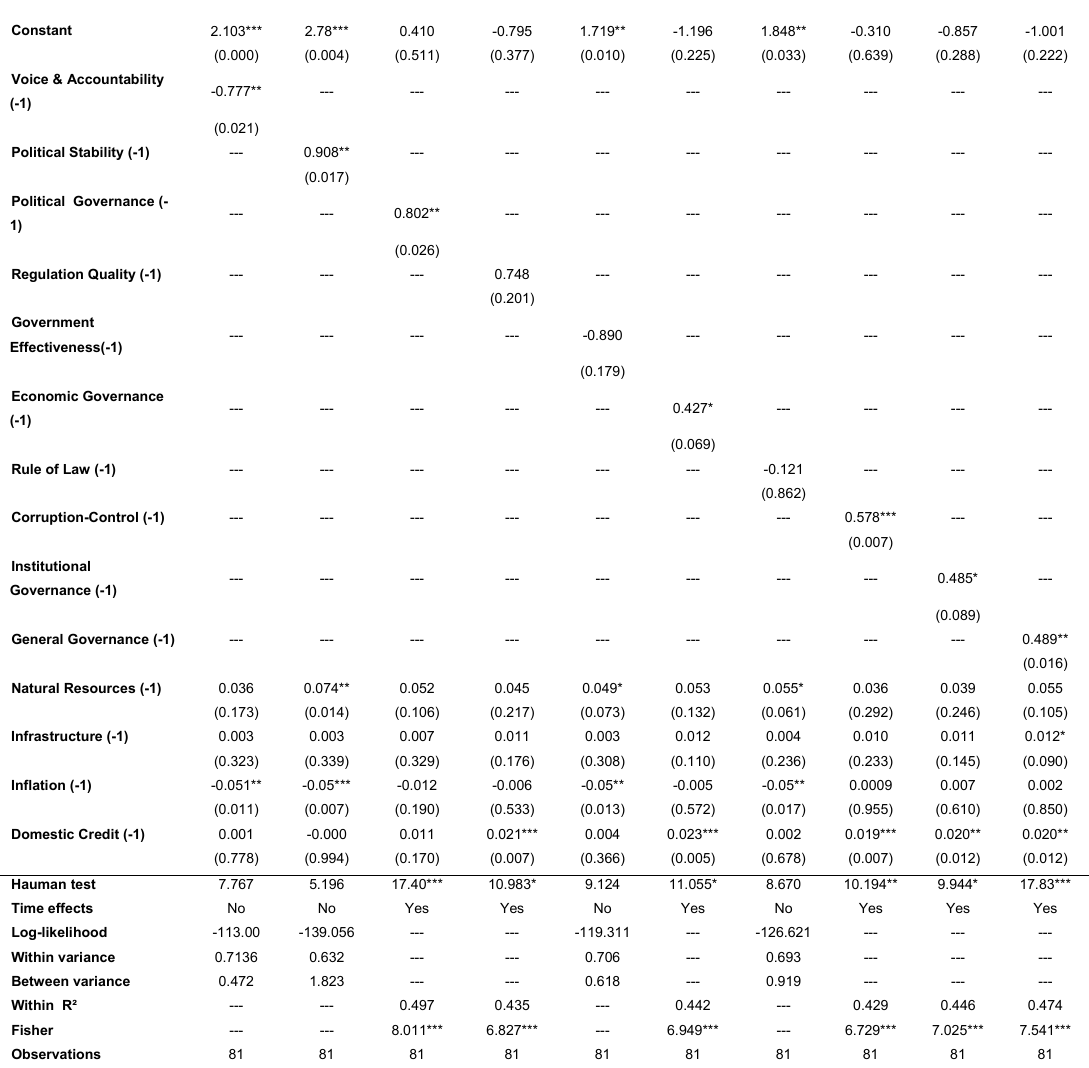
Panel A : Gross FDI